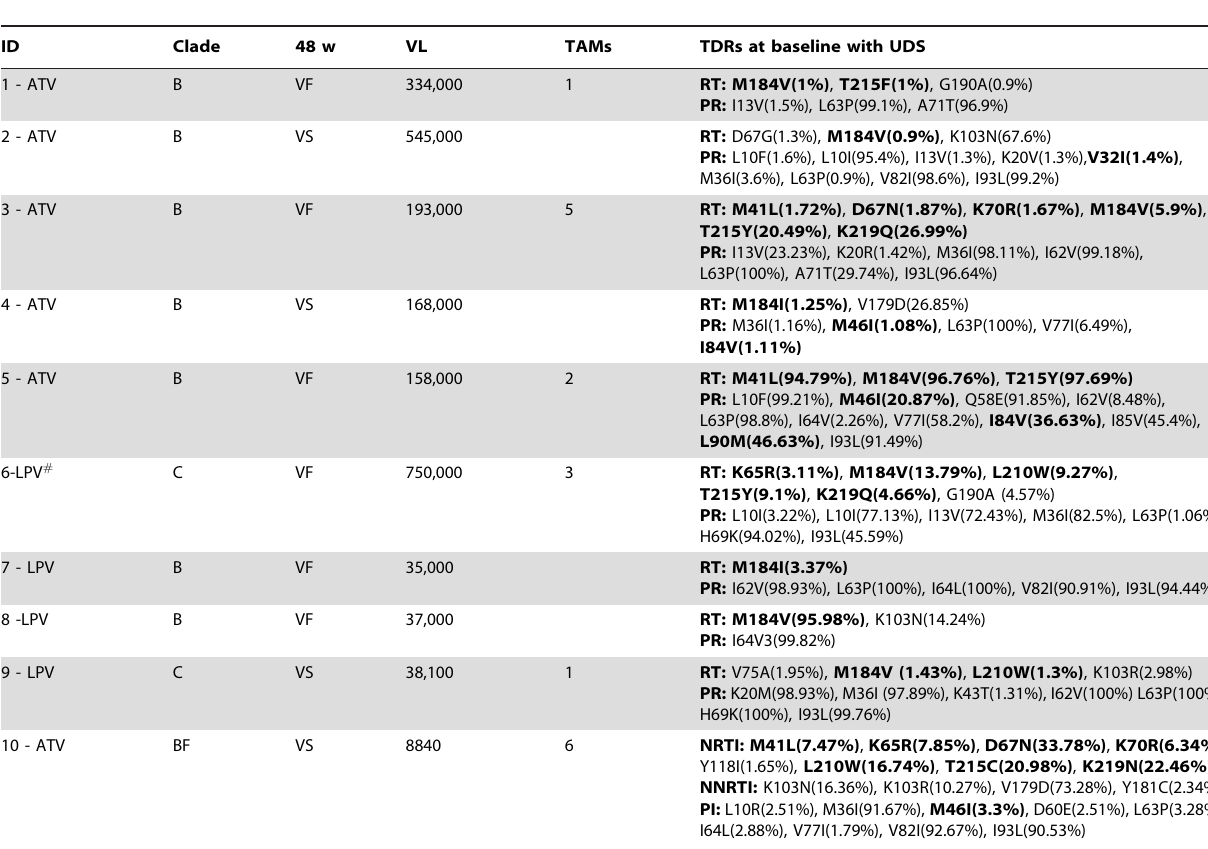
VF: Virologic Failure VS: Virologic Success NRTI: Nucleoside Reverse Transcriptase Inhibitor NNRTI: Non-Nucleoside Reverse Transcriptase Inhibitor PI: Protease Inhibitor. TAMs: Thymidine Analogue Mutations. HIV VL: HIV Viral Load. TDRs: Transmitted Drug Resistance Mutations. 6-LPV # has both a M184V and a K65R TDR. Bold: M184V, TAMs, Major PI mutations according to HIV Stanford Database. doi:10.1371/journal.pone.0010952.t004 PLoS ONE |